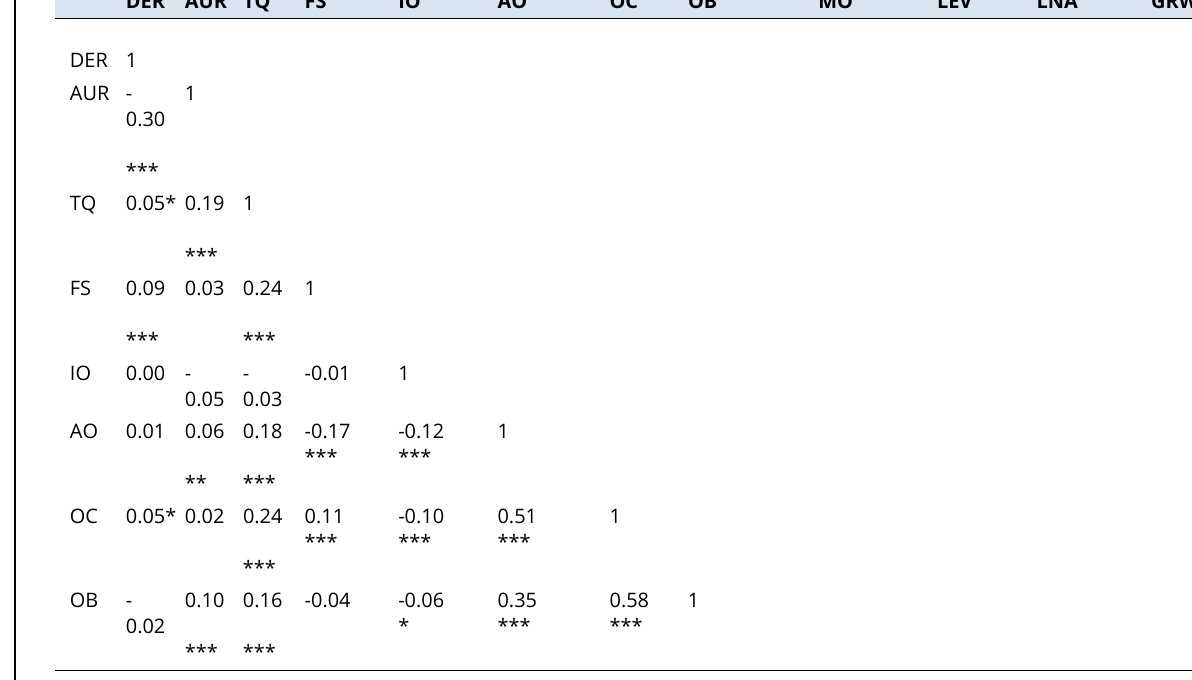
Table 2. Degree of Association measured by Pearson’s Correlation Coefficient among the Variables DER AUR